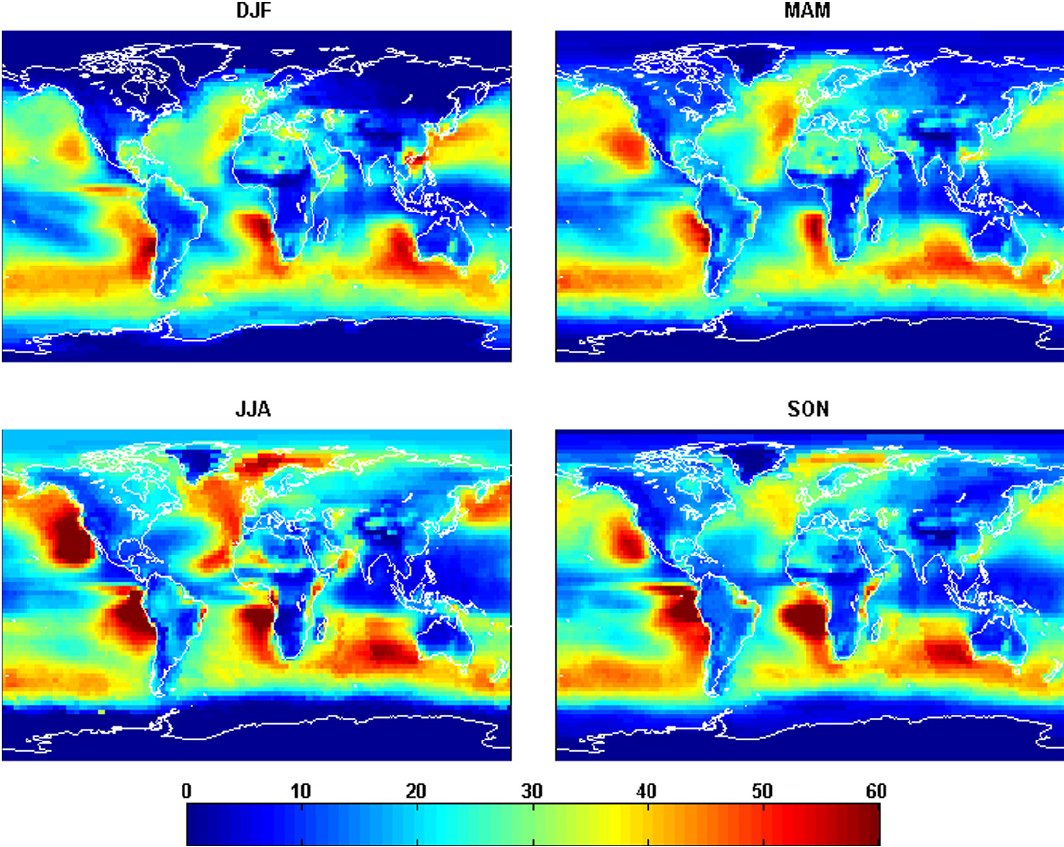
Fig. 1. A global climatological distribution (1983–2008) of daytime low level liquid water clouds derived from ISCCP D2 product for the DJF, MAM, JJA, and SON months. These data were obtained from the ISCCP website: